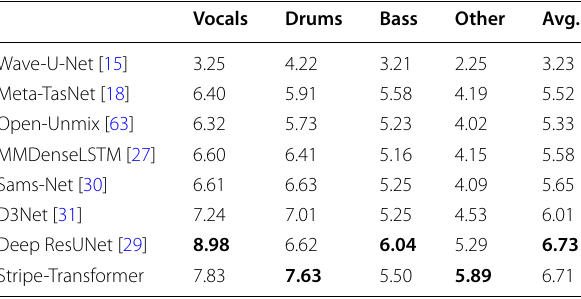
Table 3 Comparison of the SDR metric with other models on